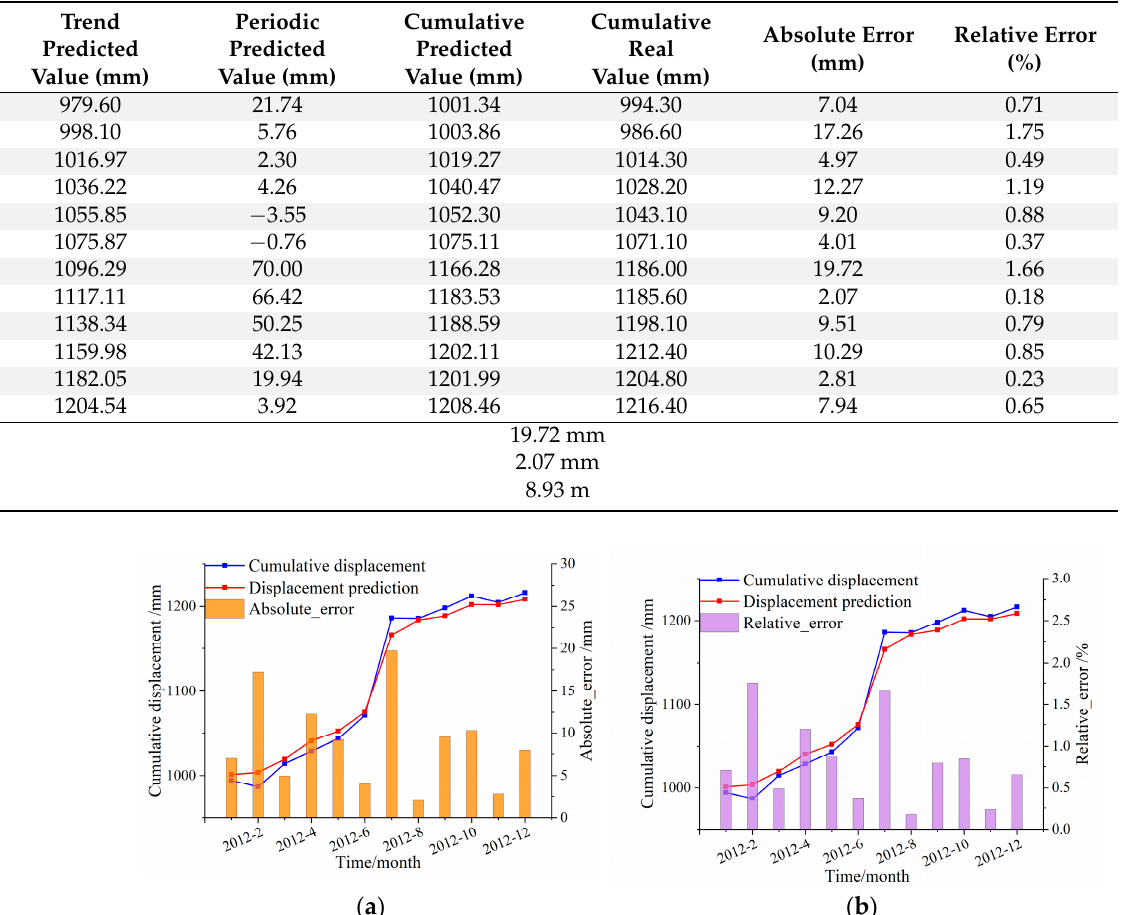
Table 4. Prediction value and error analysis results of the ZG110 cumulative displacement.